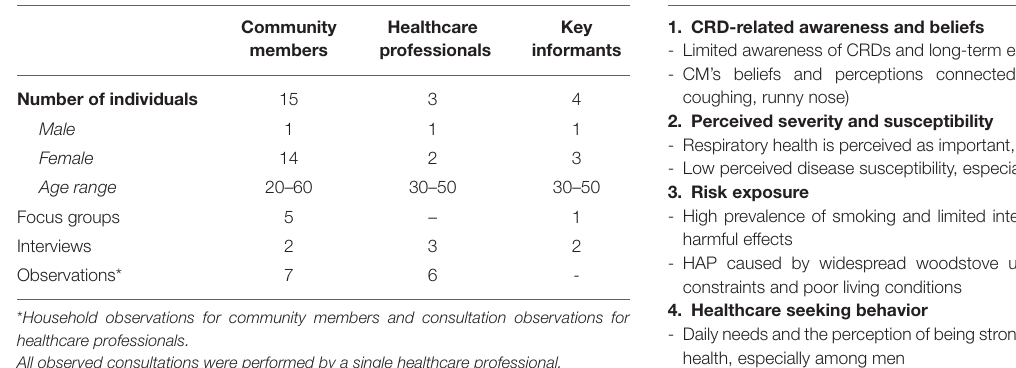
TABLE 2 | Overview of key